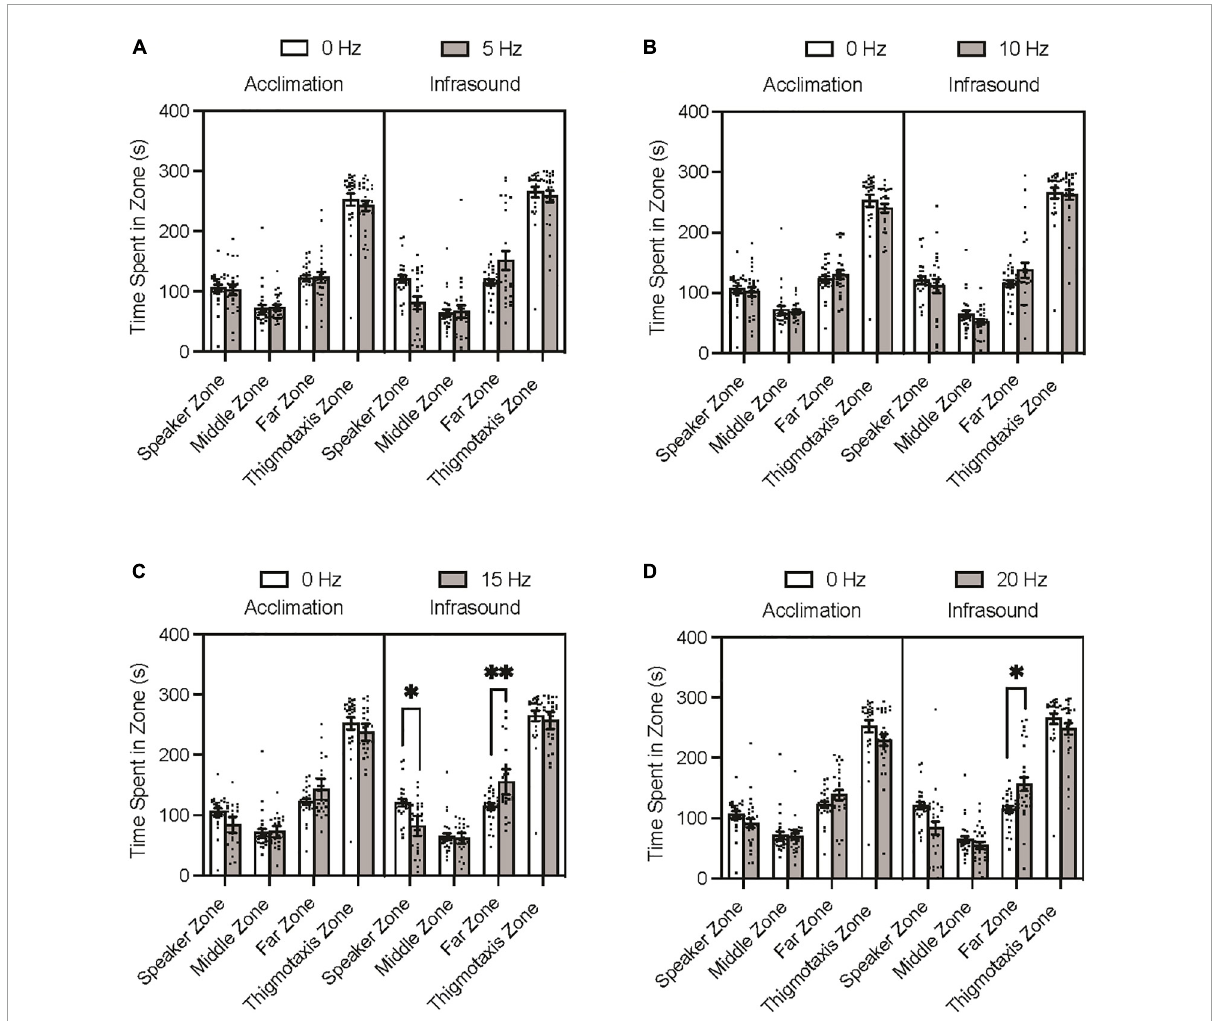
FIGURE2 Zebrafish zone preference during acclimation and infrasound exposure trials. Fish were individually placed in the arena prior to the infrasound stimulus to record their baseline behaviour and then exposed to their respective frequency. (A) Average time spent in zones by 0 vs. 5 Hz fish. (B) Average time spent zones by 0 vs. 10 Hz fish. (C) Average time spent in zones by 0 vs. 15 Hz fish. (D) Average time spent in zones by 0 vs. 20 Hz fish. Data points represent individual zebrafish. Error bars represent S.E.M. ∗ p < 0.05, ∗∗ p < 0.01.